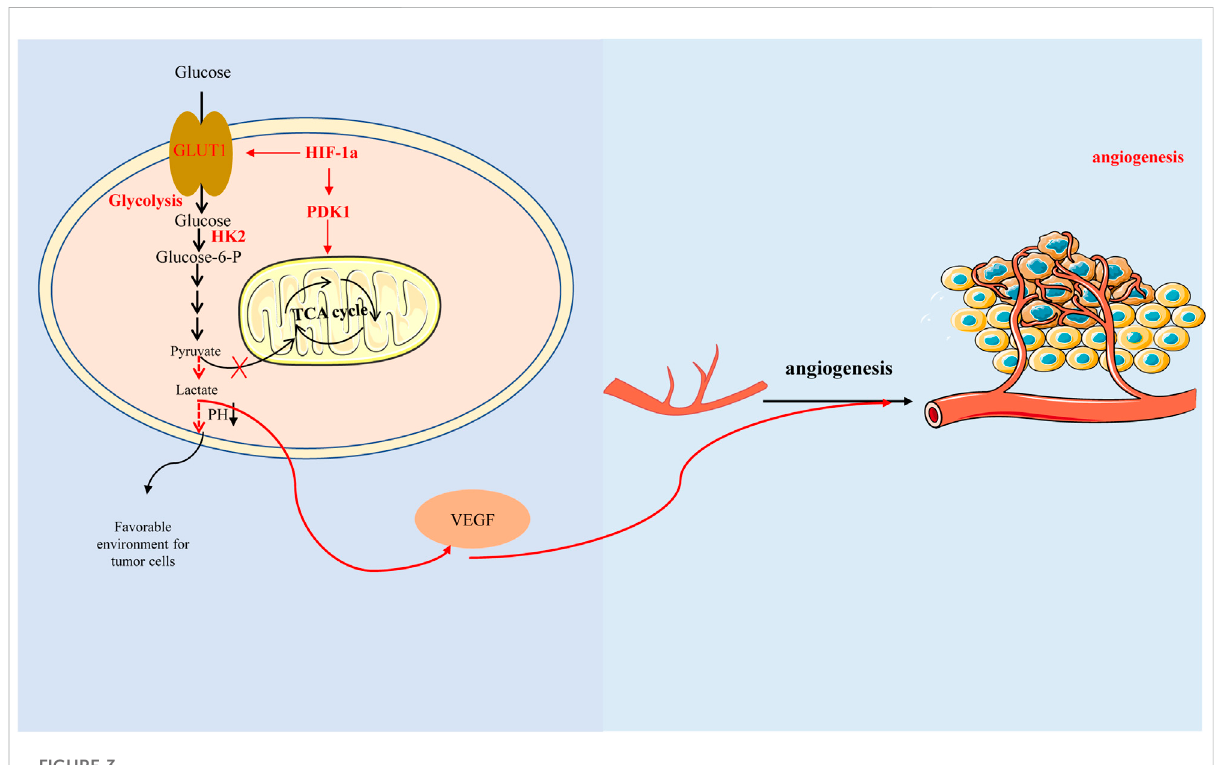
FIGURE 3 Hypoxia-inducible factor-1 α promotes glycolysis by regulating key enzymes in the process of glycolysis, which produces lactic acid acidi fi cationmicroenvironmentand affectsglucosemetabolism,thuspromotingvascular endothelial growth factorexpression andangiogenesis.In addition, HIF-1 α can also directly regulate tricarboxylic acid cycle and affect glucose metabolism with glycolysis-independent